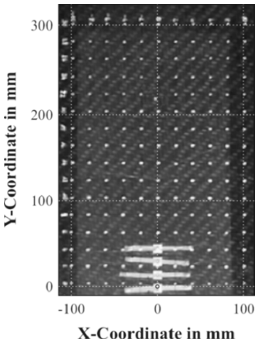
Figure 13. Coordinate system for the microphone measurement (origin at the first transducer of the array).